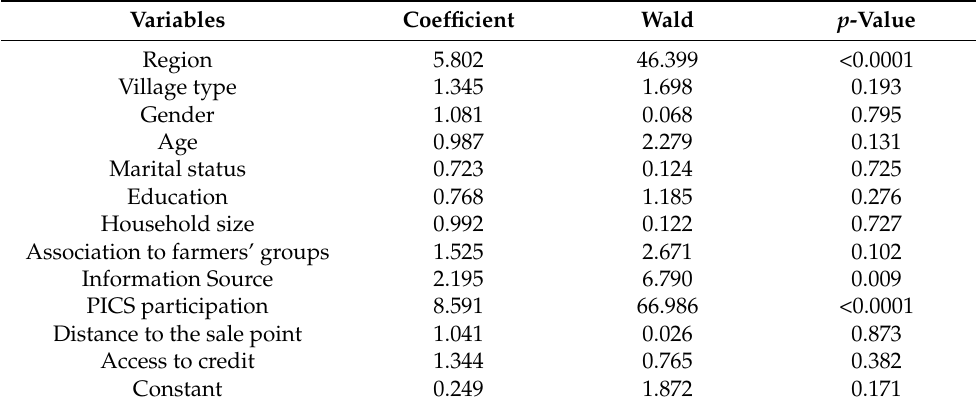
Table 4. Factors determining the adoption of PICS Bags by farmers in Dosso, Maradi, and Zinder regions of Niger.